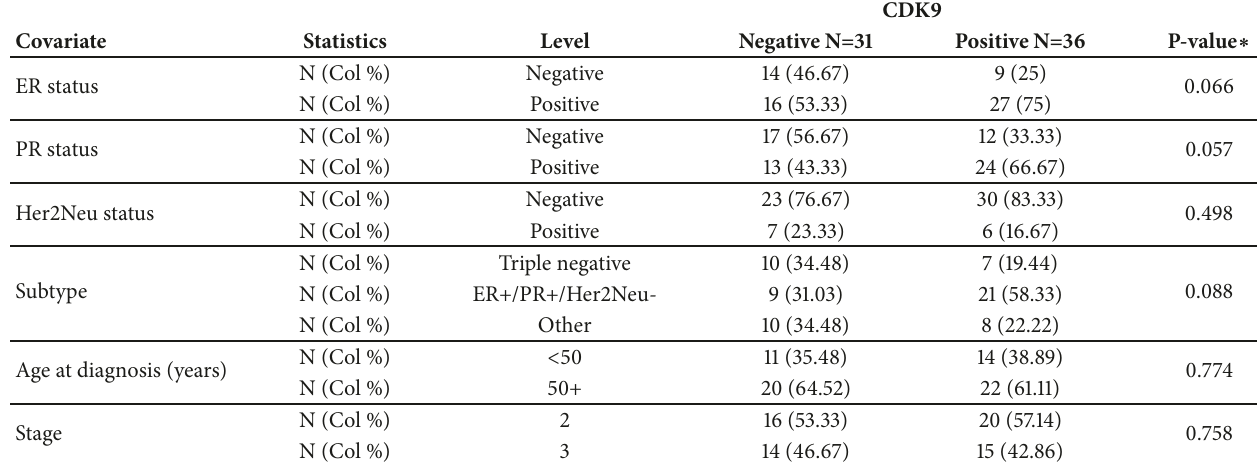
Table 3: CDK 9 e x pression andbreast cancersubt y pe / receptor status . This tables shows no significant association of CDK9 expression with breast cancer subtype and receptor